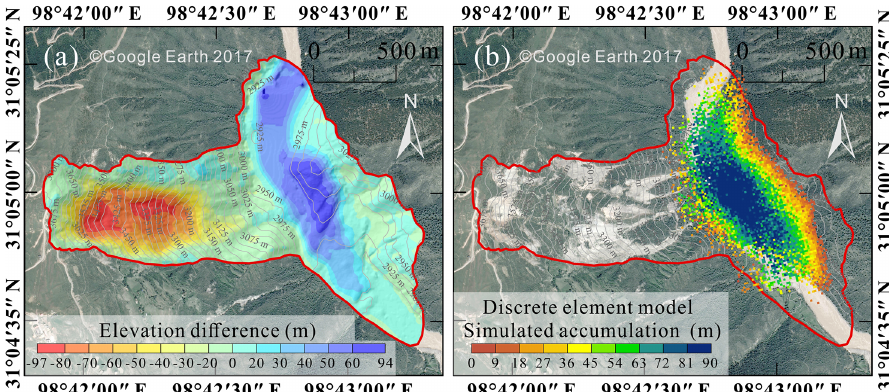
https://doi.org/10.5194/esurf-10-1233-2022 Earth Surf. Dynam., 10, 1233–1252,